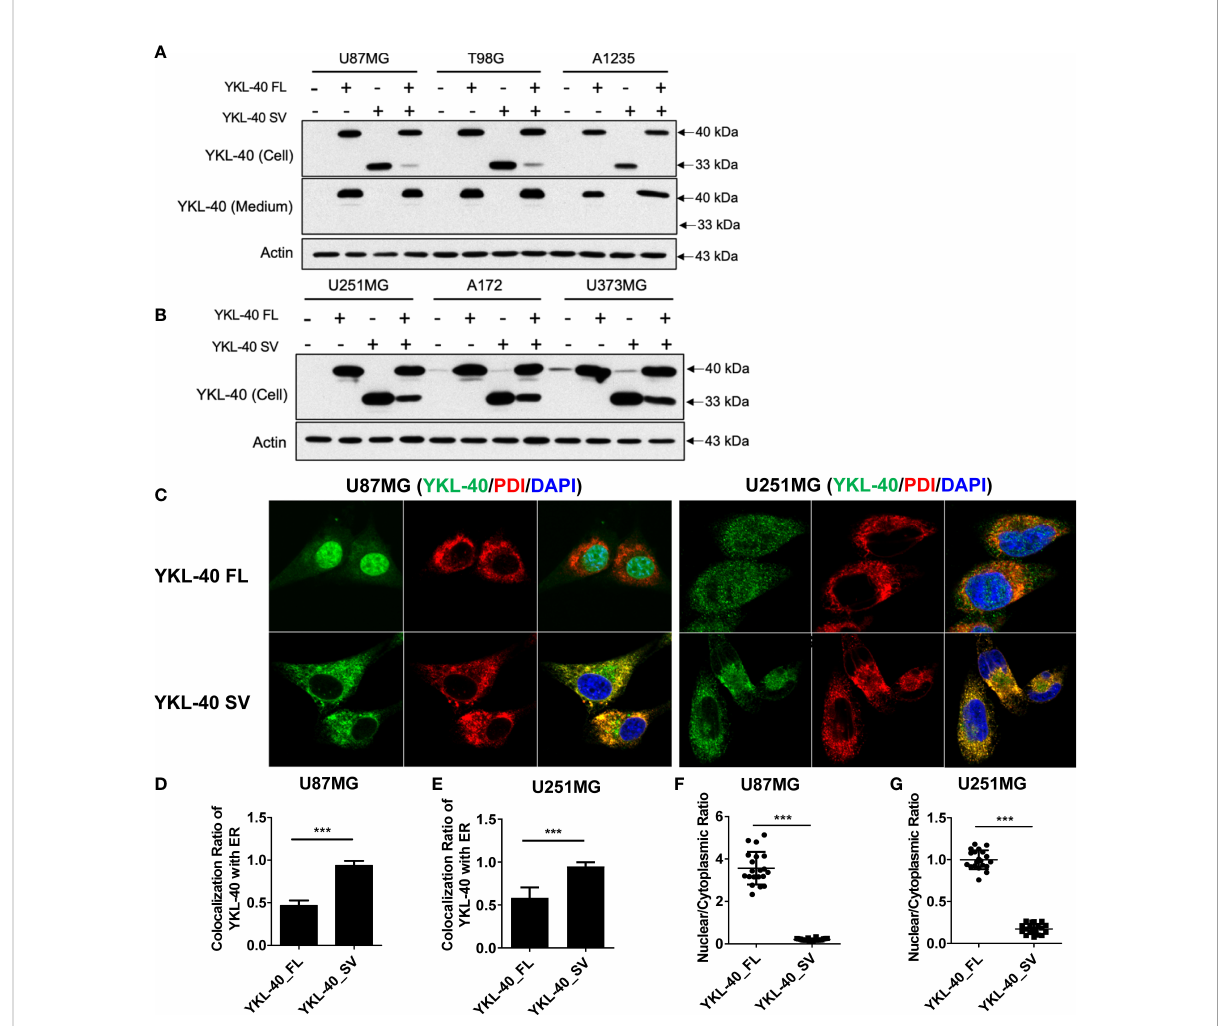
FIGURE 3 Distinct subcellular distribution of YKL-40 full-length (FL) and short variant (SV) isoforms in GBM cell lines. (A, B) GBM cell lines with stable overexpression of both isoforms of YKL-40 were established by retroviral transfection, and the expression and secretion of YKL-40 were detected by Western blot analysis. (C) U87MG and U251MG stable lines overexpressing FL and SV YKL-40 were fi xed and stained with anti-YKL- 40 and anti-PDI antibodies, followed by Alexa Fluor 488 (green) and Alexa Fluor 555 (red) conjugated secondary antibodies. Cell nuclei were stained with DAPI (blue) (magni fi cation 600×). (D, E) The colocalization ratio of YKL-40 to the ER marker PDI was calculated using Fiji-ImageJ software with the Coloc 2 plugin. (F, G) The nuclear to cytoplasmic localization ratio of YKL-40 was quanti fi ed using Fiji-ImageJ. (Bars, SD. Student ’ s t -test. *** p < 0.001. The relative intensity of YKL-40 was quanti fi ed from 15 to 25 individual